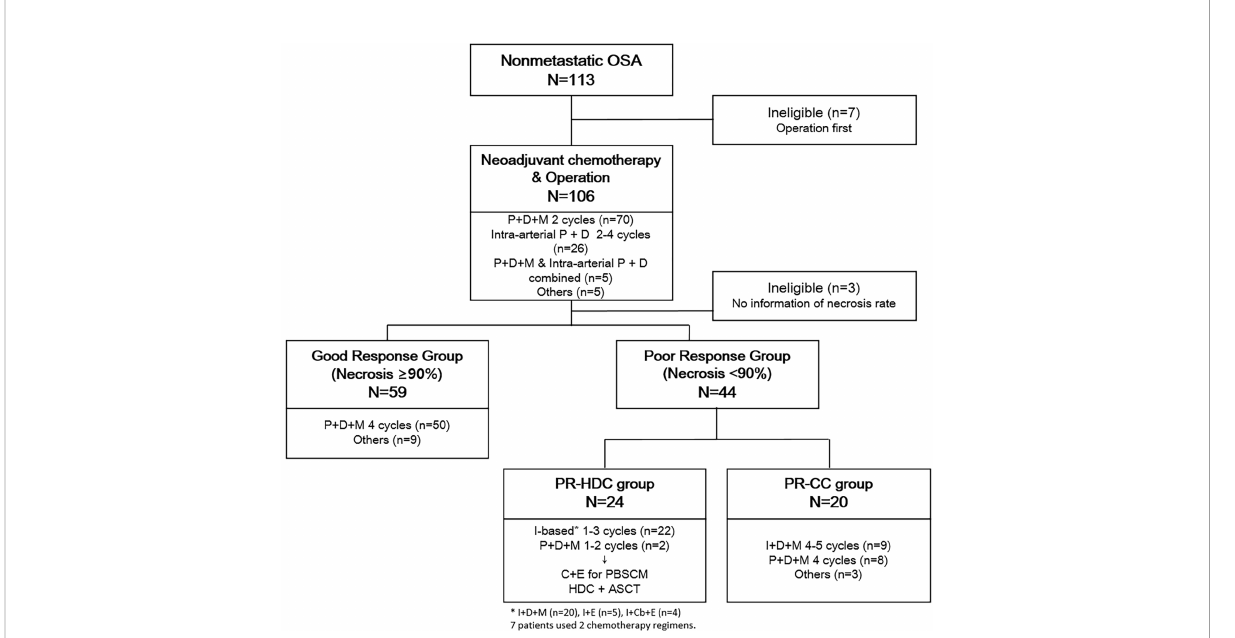
FIGURE 1 Overall treatment scheme and classi fi cation of patients. ASCT, autologous hematopoietic stem cell transplantation; C, cyclophosphamide; Cb, carboplatin; D, doxorubicin; E, etoposide; I, ifosfamide; P, cisplatin; PR-CC, poor response-chemotherapy only; PR-HDC, poor response-high dose